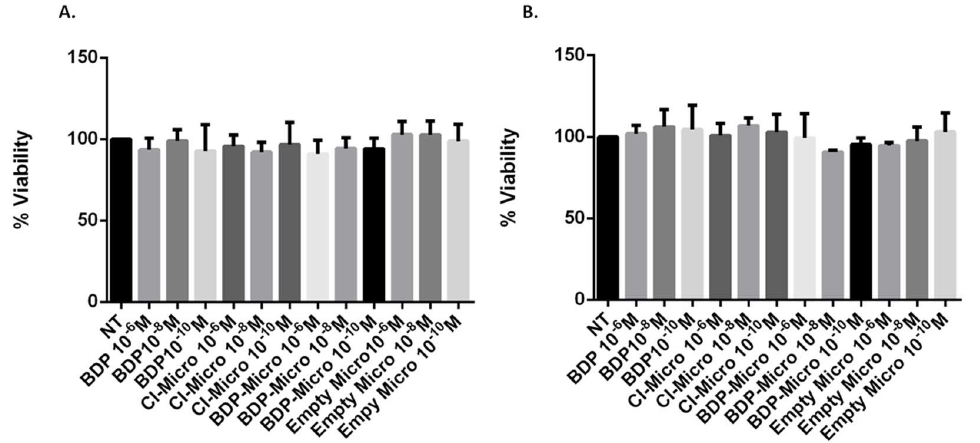
Figure 5. Cell viability in 16HBE and A549 cells. 16HBE ( A ) and A549 ( B ) cells were incubated for 24 h with BDP in dispersion (BDP), with empty particle (Empty Micro) and with BDP incorporated into the MP systems (CI-Micro or BDP-Micro) at different concentrations (10 −6 , 10 −8 and 10 −10 M). Cell viability was assessed by MTS viability assay. Mean values ± standard deviations (error bars) are reported ( n = 6).